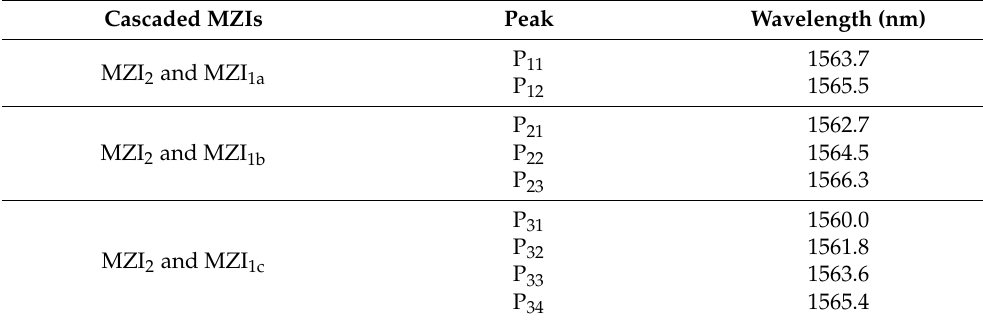
Table 2. Measured transmission spectra of the MZI 2 connected in series with the (a) MZI 1a , (b) MZI 1b , (c) MZI 1c , and (d) MZI 2 (cascade